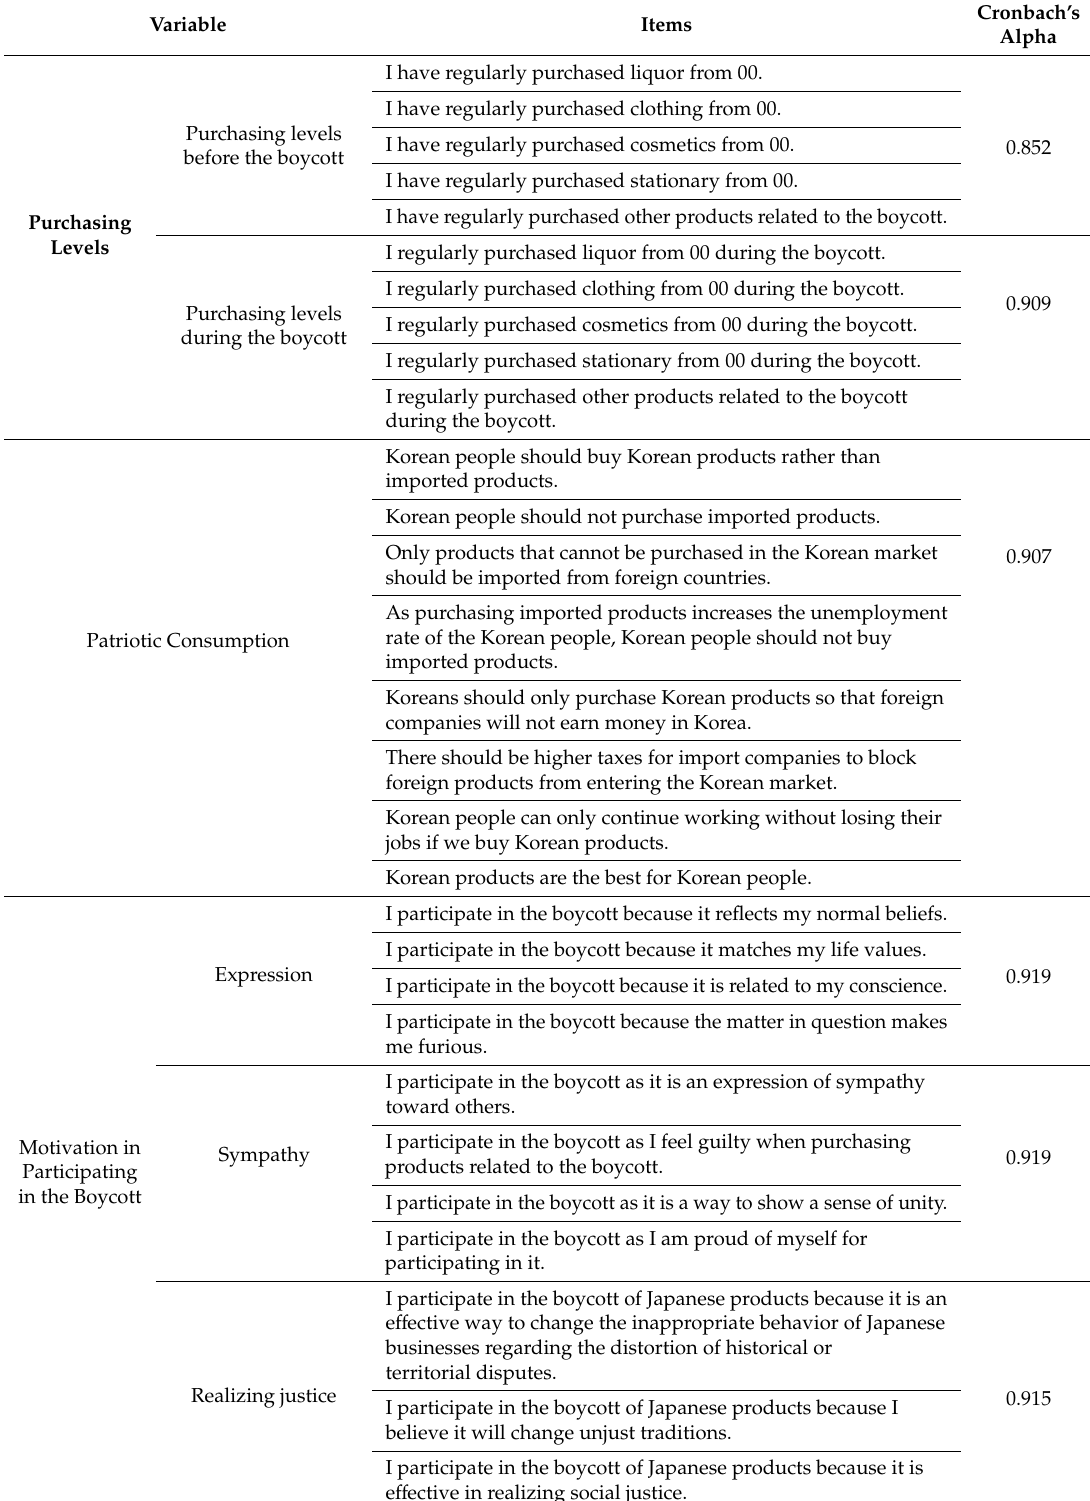
Table 1. Scale items and reliability analysis